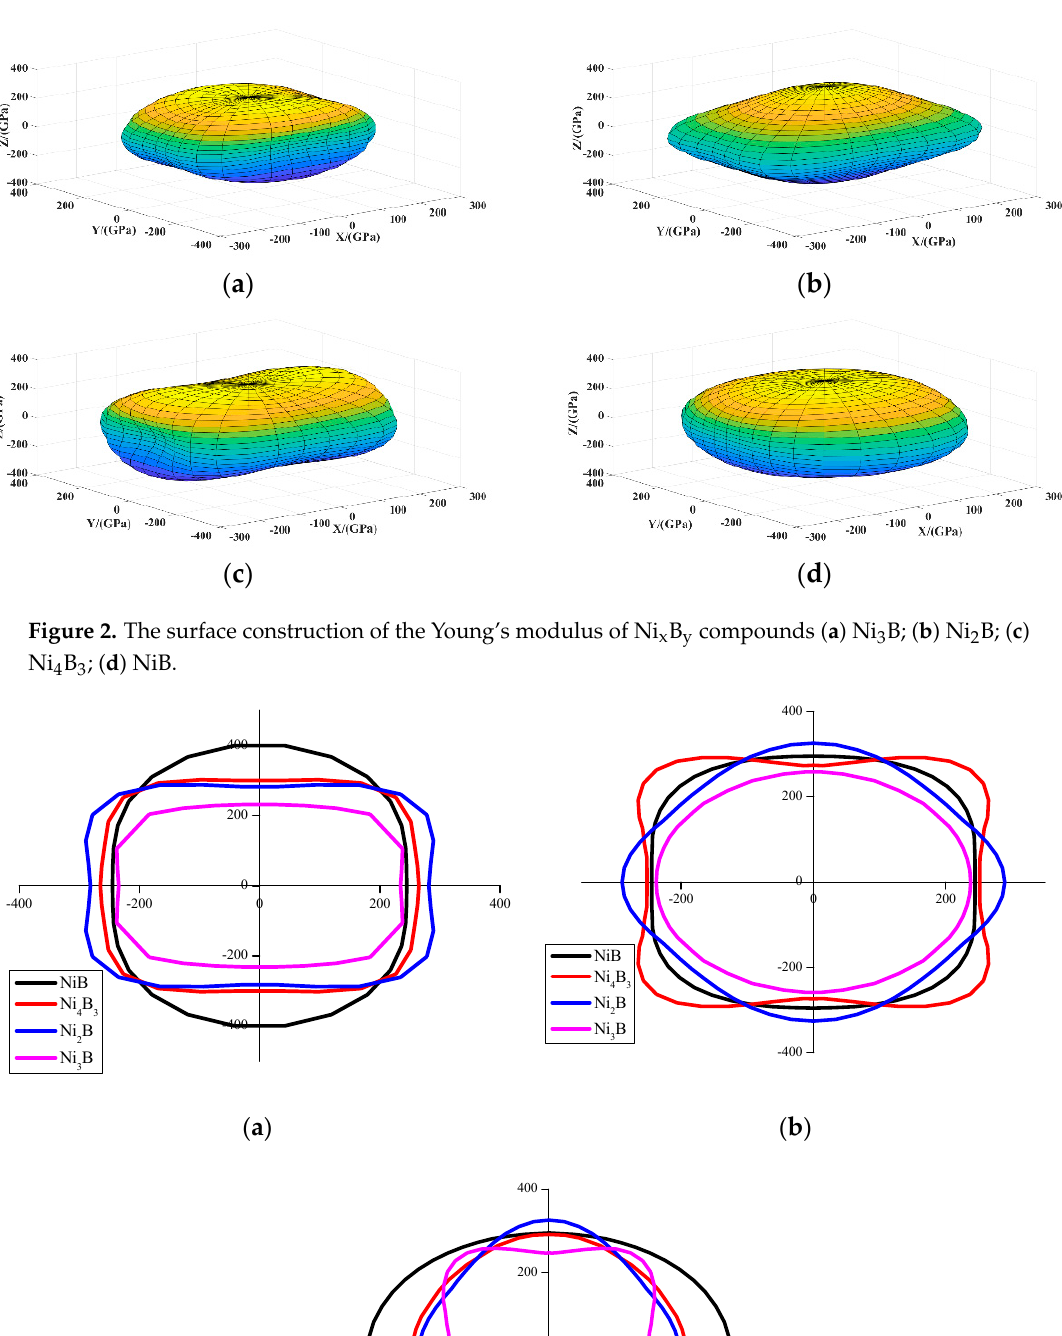
Figure 2. The surface construction of the Young’s modulus of Ni x B y compounds ( a ) Ni 3 B; ( b ) Ni 2 B; ( c ) Ni 4 B 3 ; ( d ) NiB.